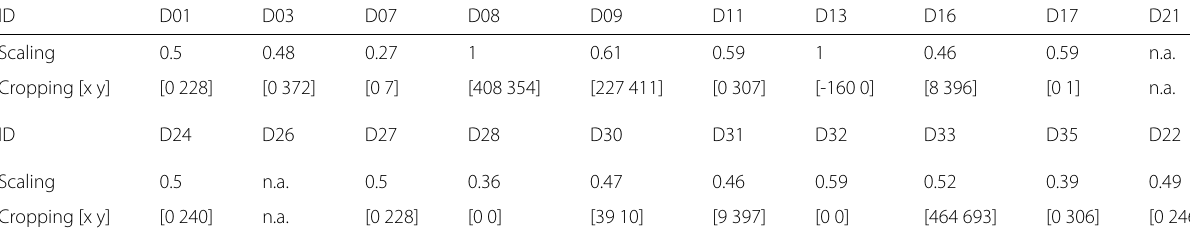
Table 4 Estimated Cropping and Scaling factors for non stabilized